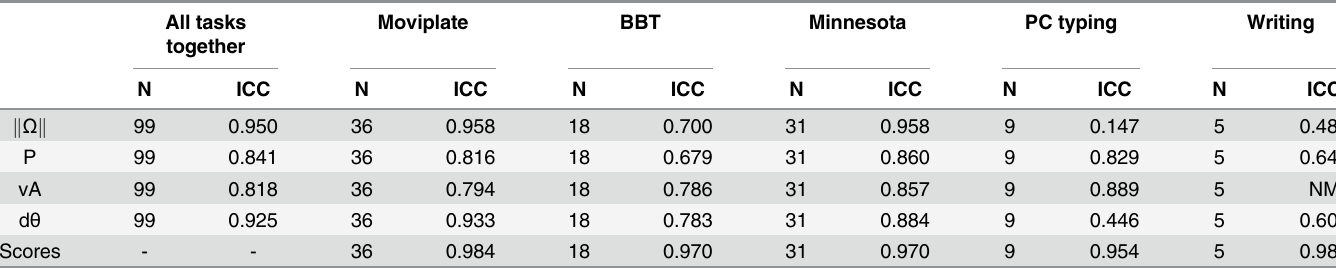
Table 4. Reliability of tasks between test and retest of ActiMyo 1 inertial variables and task scores. All tasks Moviplate BBT Minnesota PC typing together